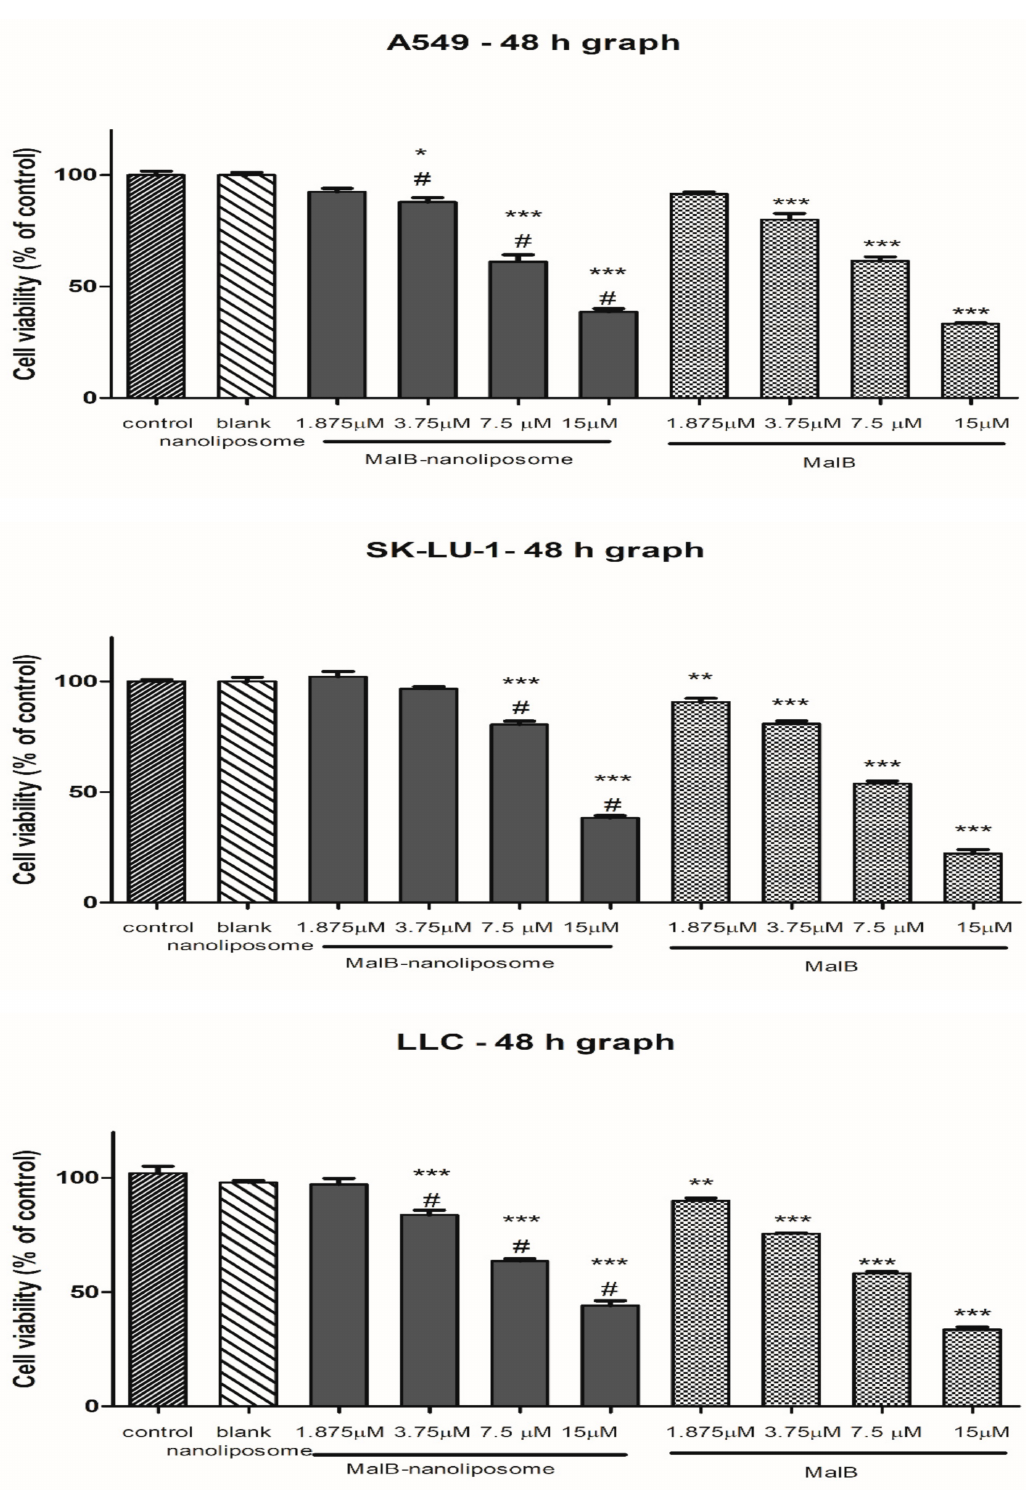
Figure 2. Cell viability after 48 h under the treatment of malB-nanoliposome C or free compound on di ff erent lung cancer cell lines. Cultured cells (2 × 10 3 cells / well) were treated with di ff erent concentrations of either malB-nanoliposomal or free malB. Normal saline served as the negative control. Each value represents the mean ± SEM. One-way ANOVA was used for analyzing statistical di ff erences between groups. * p < 0.05, ** p < 0.01, *** p < 0.001 when compared with negative control. # p < 0.01 when compared with blank